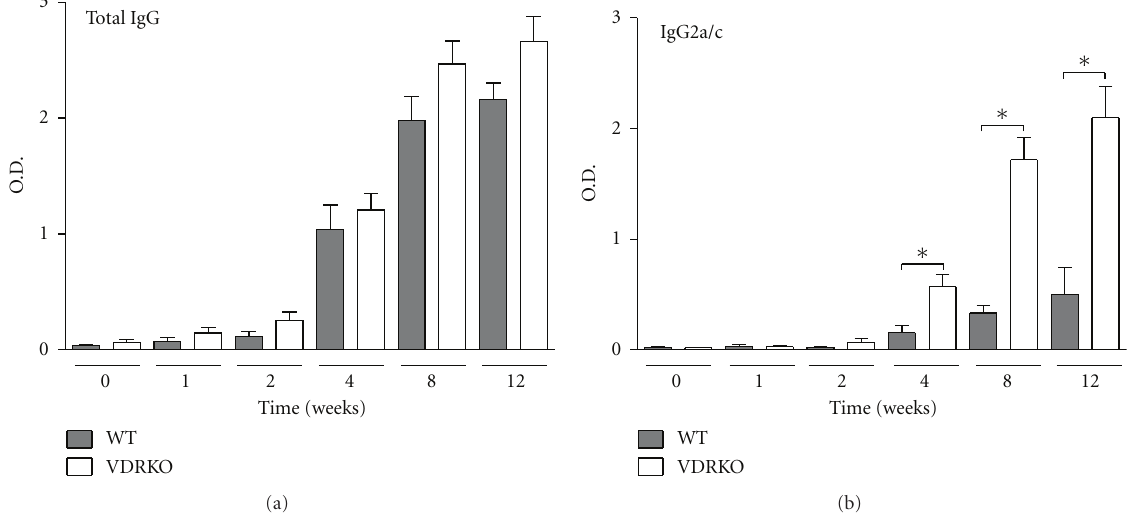
Figure 6: VDRKO mice exhibit elevated IgG2a/c production in response to L. major infection. C57BL/6 WT (closed bars) and VDRKO (open bars) mice were infected with 10 5 L. major parasites and serum samples were collected at the indicated time points. Isotype specific ELISA was performed to determine levels of total IgG and IgG2a/c in the serum. Mean ± SE is presented; n = (8–10). ∗ P ≤ 0 . 05. One representative of two independent experiments is presented.